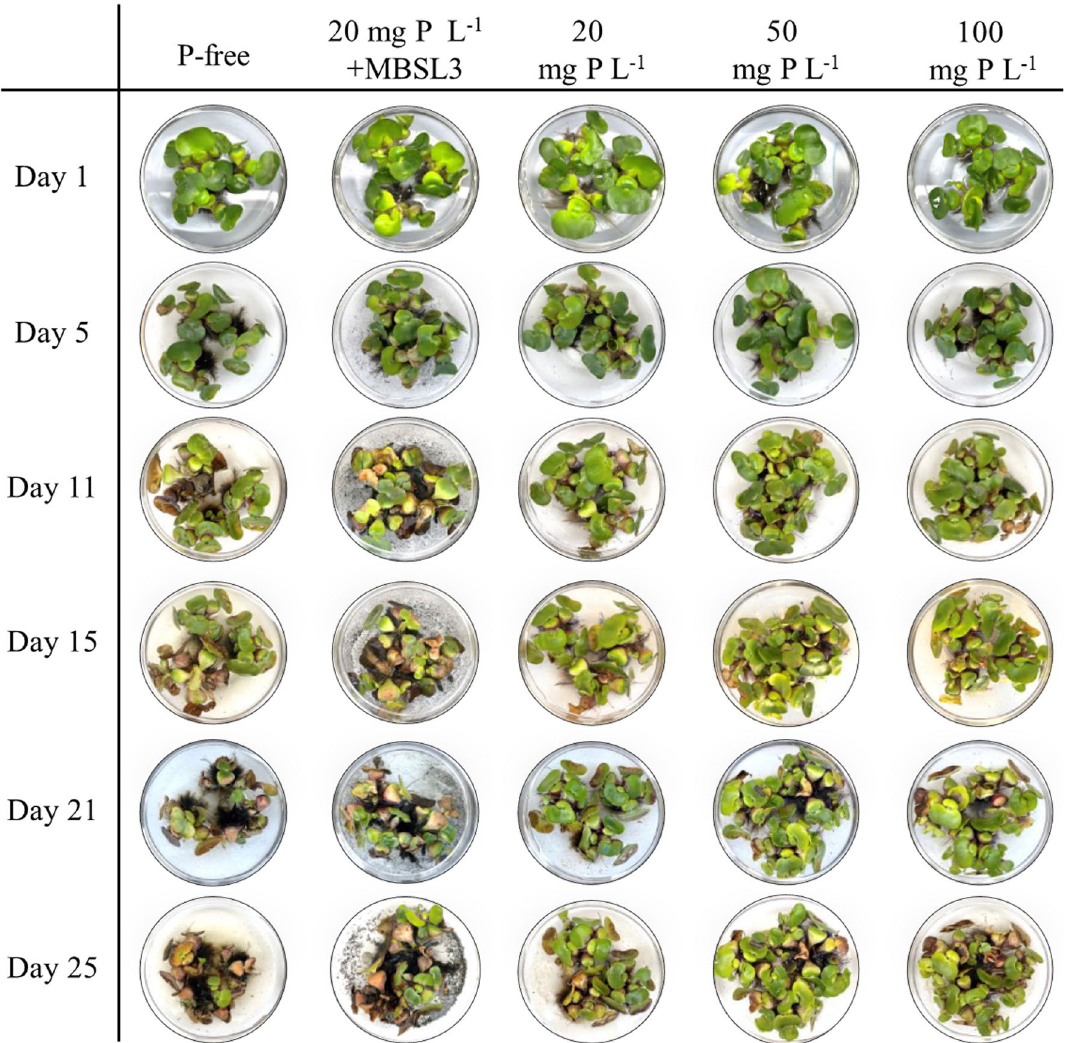
Fig. 6 The growth trend of water hyacinth at different P